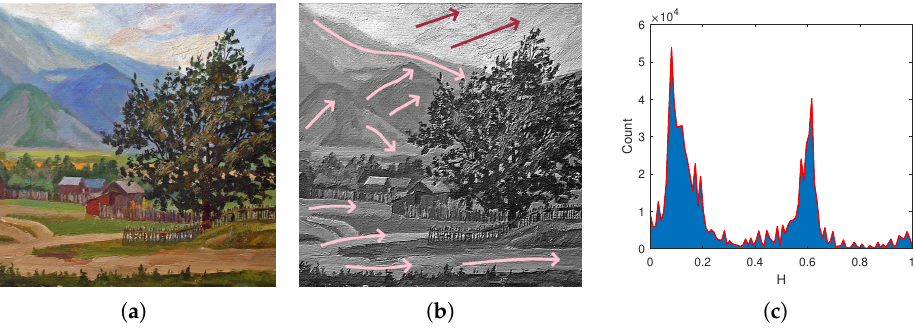
Figure 1. ( a ) The original image. It has a blue pale background due to aerial perspective. ( b ) The predominant directions of brushstrokes in some regions of the image. In these regions, the brush- strokes are highly coherent. ( c ) The hue histogram showing that it has two distinct peaks near complementary colors: orange H = 0.1 and blue H =